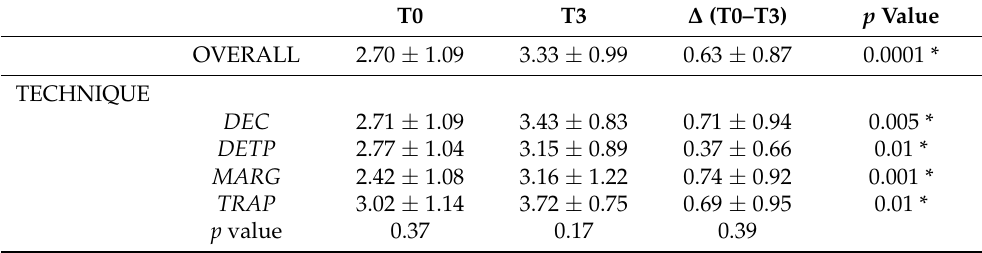
Table 8. Second molar buccal site CAL. Values are presented in mm as mean ( ± standard deviation). T0